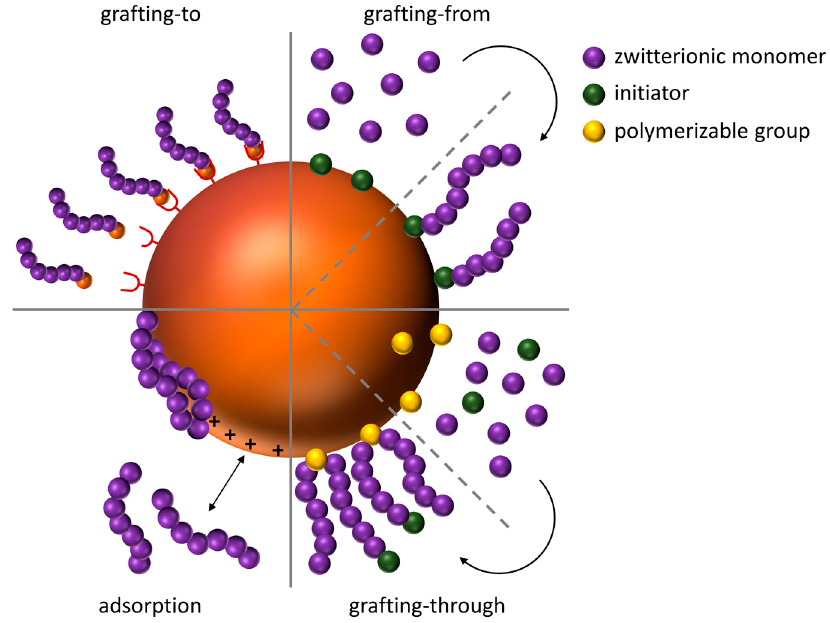
Figure 3. Schematic representation of different grafting methods of polymers to nanoparticle surfaces.